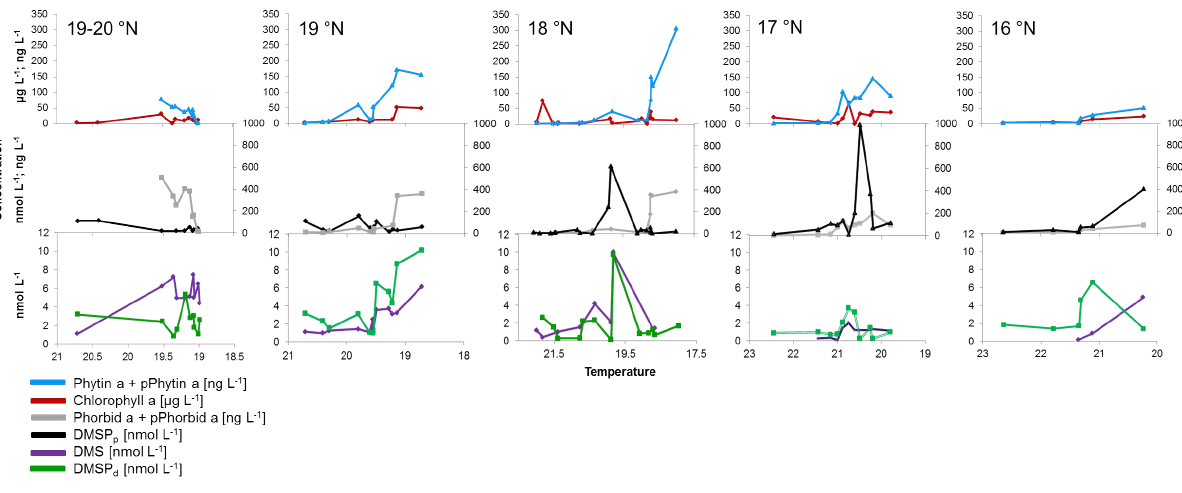
Fig. 5. Distribution of DMS, DMSP d , DMSP p , sum of Phorbida and pPhorbida, sum of Phytina and pPhytina and chlorophyll- a in 5m depth along onshore-offshore transects between 16 ◦ and 20 ◦